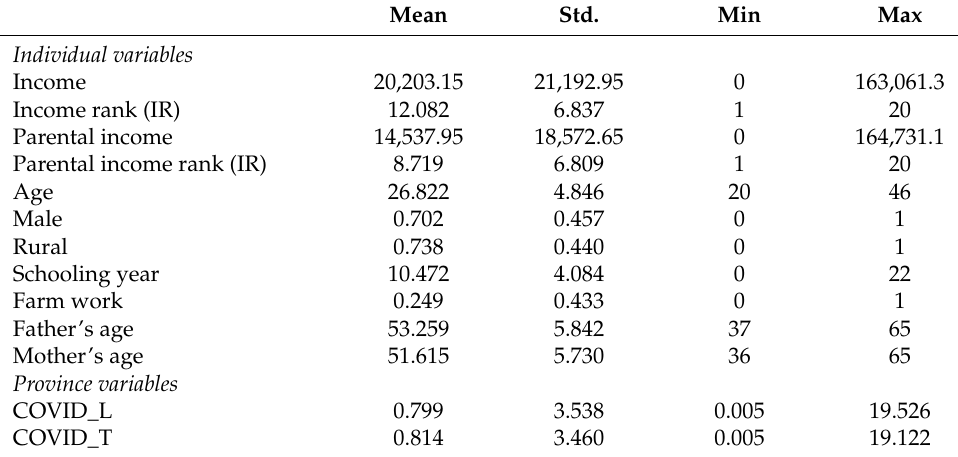
Table 1. Summary statistics of main